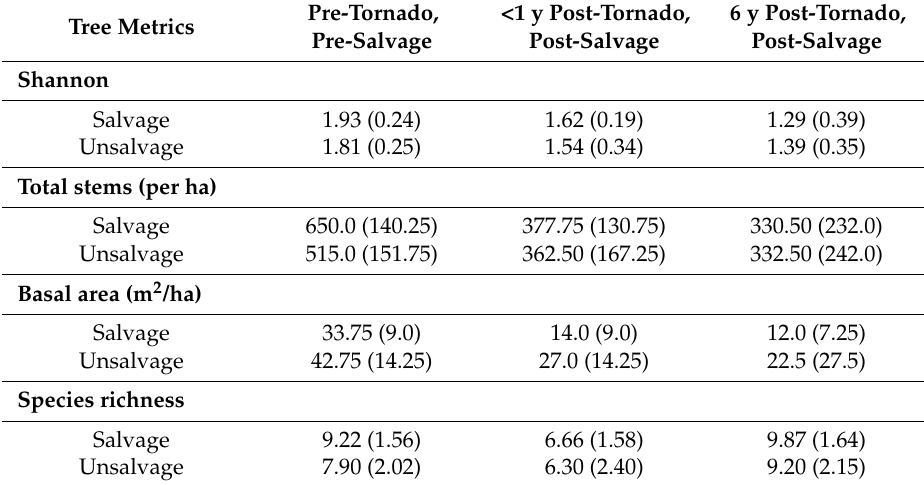
Table 1. Shannon diversity, total stems, basal area, and species richness for pre-tornado, <1 year post-tornado, and 6 years post-tornado salvaged and unsalvaged plots ( ± Standard Deviation) of